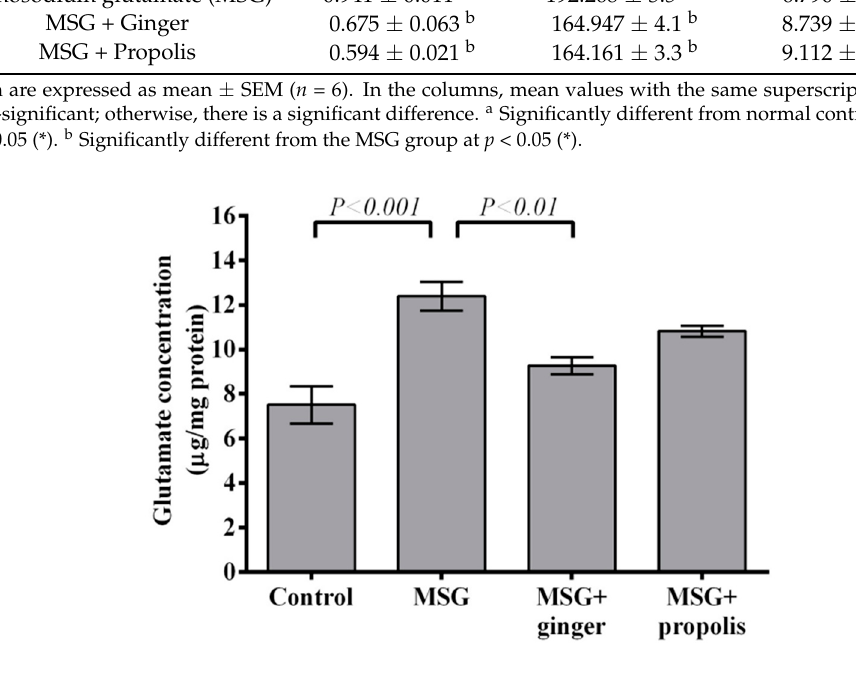
Figure 15. Cerebral cortex glutamate concentration at two months post-treatment. Data are expressed as mean ± SEM ( n = 6). Comparisons were made between normal control and MSG control groups, and between MSG control and MSG plus ginger or propolis supplement groups as well. No significant difference between MSG group and MSG plus propolis as well as normal control and MSG plus ginger (data not shown).